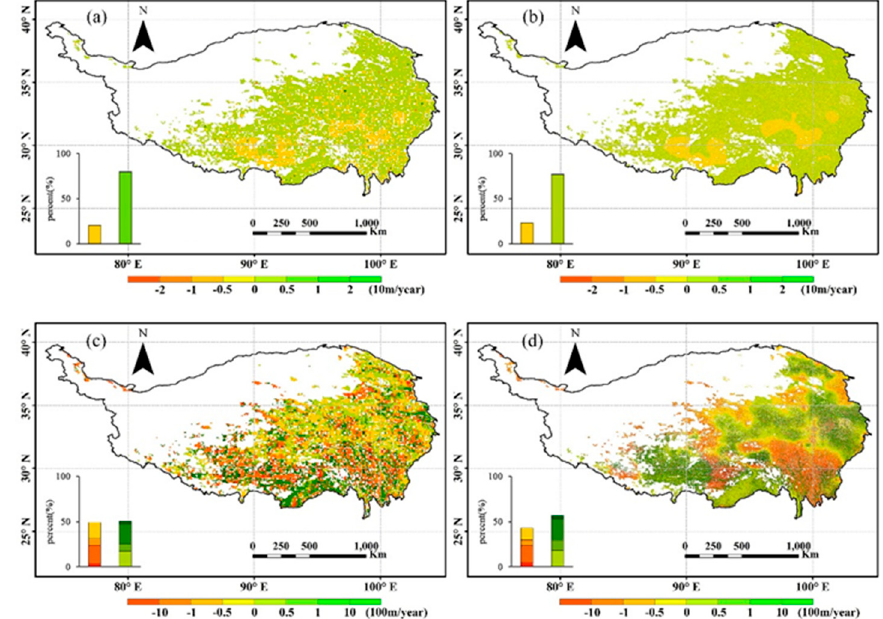
Figure 6. Spatial patterns of elevational variation rate of ( a ) temperature isolines with a spatial resolution of 0.1 degrees, ( b ) temperature isolines with a spatial resolution of 1 km, ( c ) precipitation isolines with a spatial resolution of 0.1 degrees, and ( d ) precipitation isolines with a spatial resolution of 1 km.